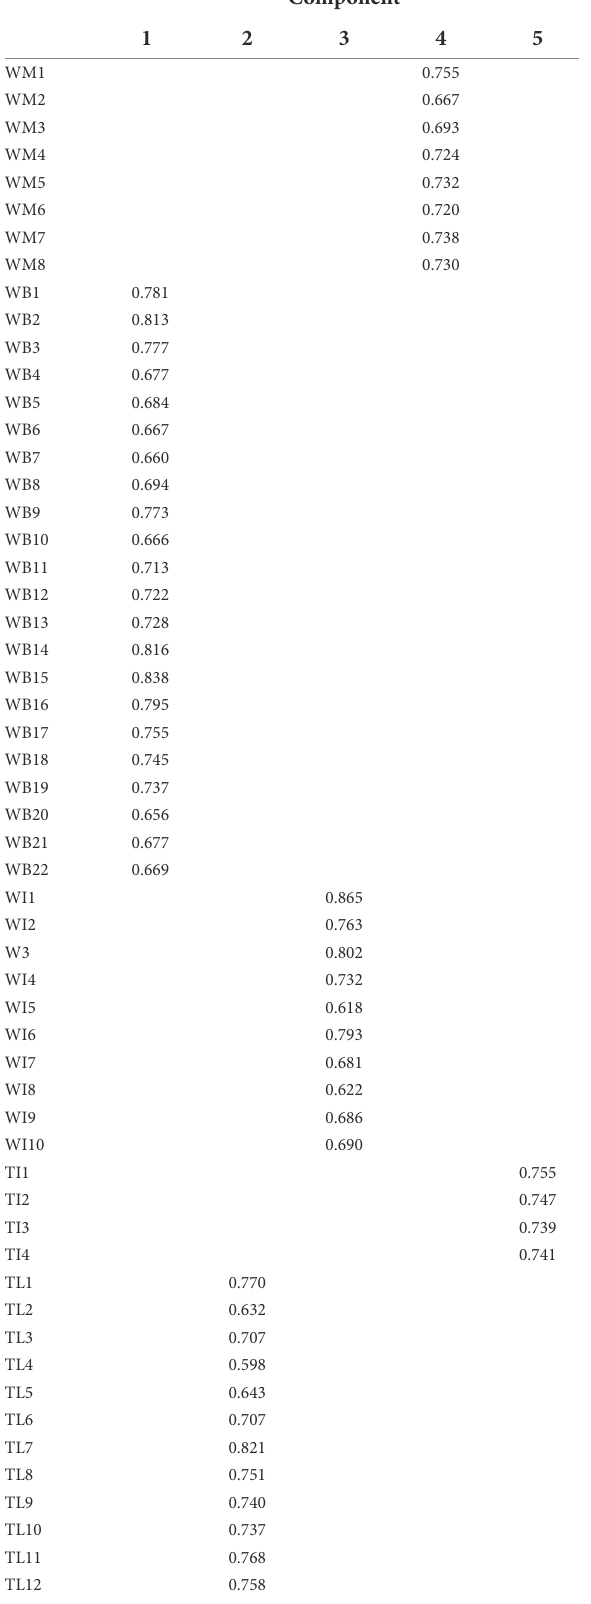
TABLE 4 Rotated component